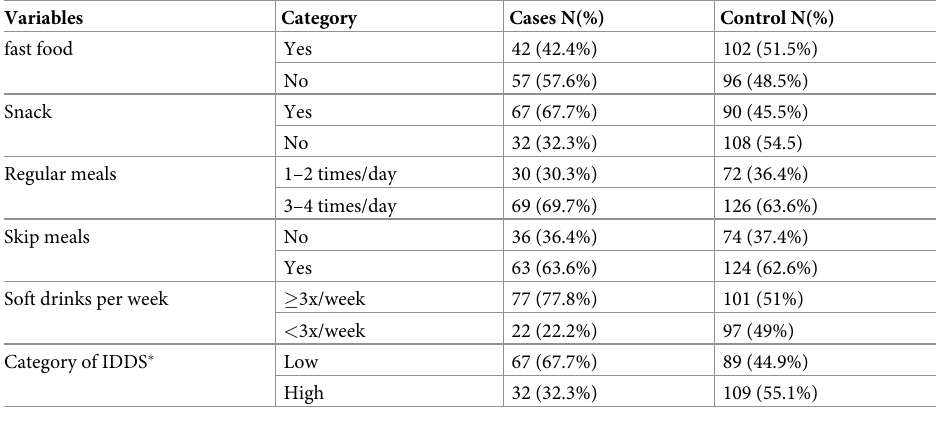
Table 2. Distribution of dietary-related factors of overweight and/or obesity among school adolescents in Butajira Town, southern Ethiopia, 2019.